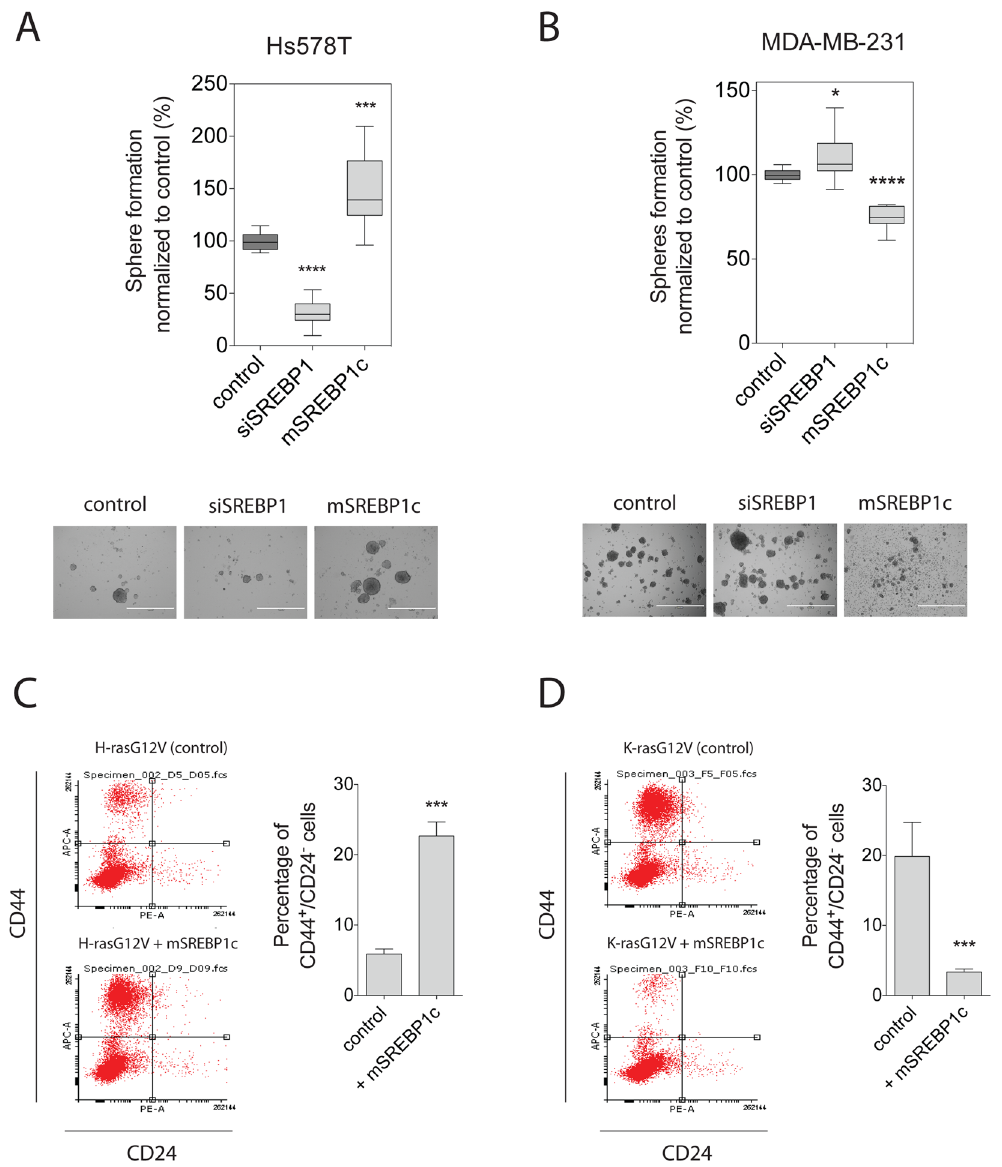
Figure 6. Ras isoform-driven stemness properties are oppositely altered by mSREBP1c. ( A , B ) Mammosphere- forming efficiency was measured for Hs578T ( A ) or MDA-MB-231 ( B ) breast cancer cells transfected with SREBP1 siRNA or mSREBP1c vector. Mammospheres were allowed to form for 9 days. The mammosphere- forming efficiency was measured as the number of spheres formed and normalized to control (mean ± SEM, n = 3). Representative images of spheres are shown below the plots. Scale bar represents 1000 μ m. ( C , D ) Left , CD44/CD24 FACS profiles are shown for HEK cells expressing ( C ) H-rasG12V or ( D ) K-rasG12V and after mSREBP1c expression. Right , shown is the average percentage of CD44 + /CD24 − HEK cells for each condition. Error bars denote the SEM from three independent experiments performed in duplicate. Statistical significance levels are annotated as * p < 0.05; *** p < 0.001; **** p <